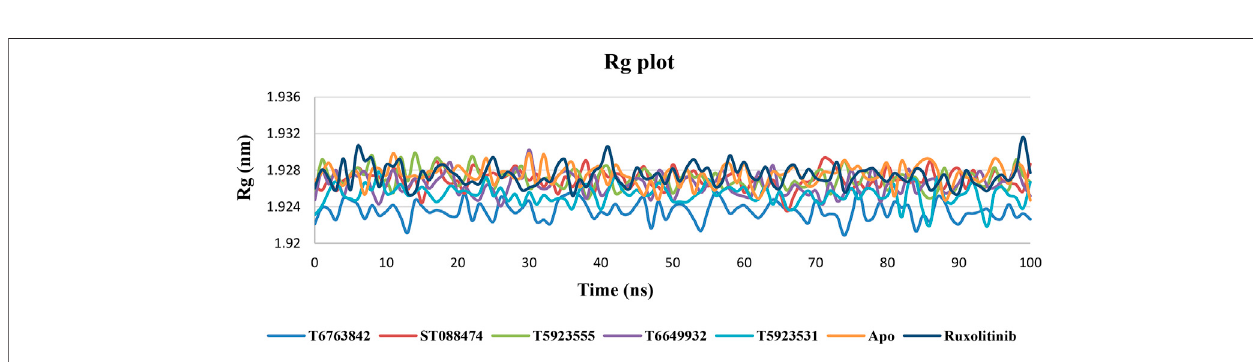
FIGURE 7 | The change in Rg values over a period of 100 ns after binding with the lead compounds and drug.